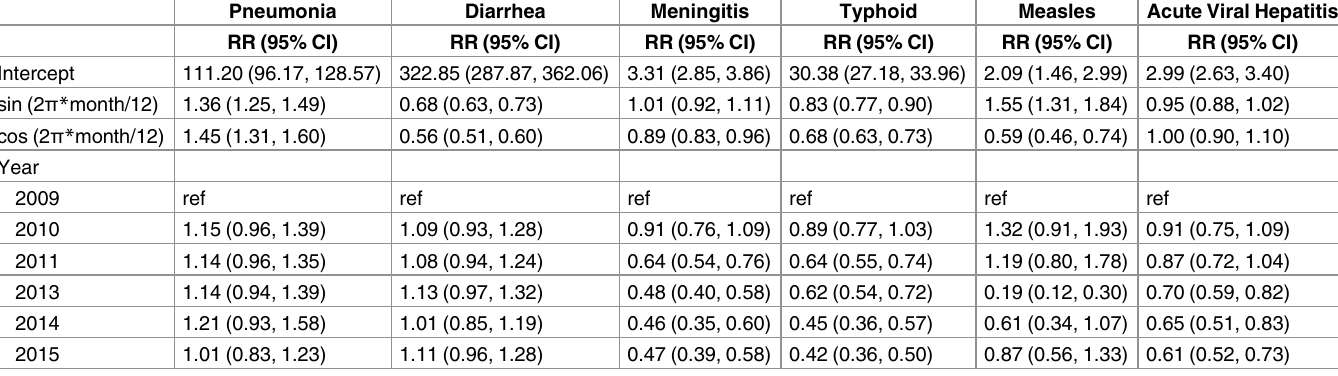
Table 2. Cyclical and long-term trends in the incidence of suspected cases of six diseasesfrom Afghanistan’s DiseaseEarly Warning System, 2009–2015.